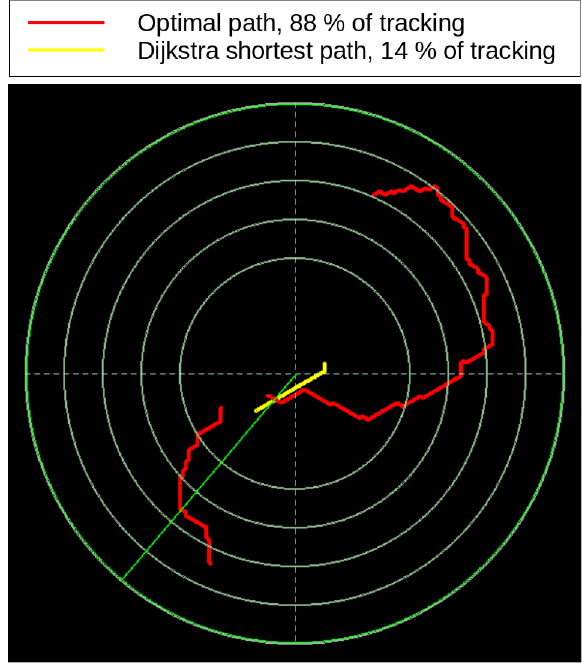
Figure 18. Optimal path Vs Dijkstra shortest path